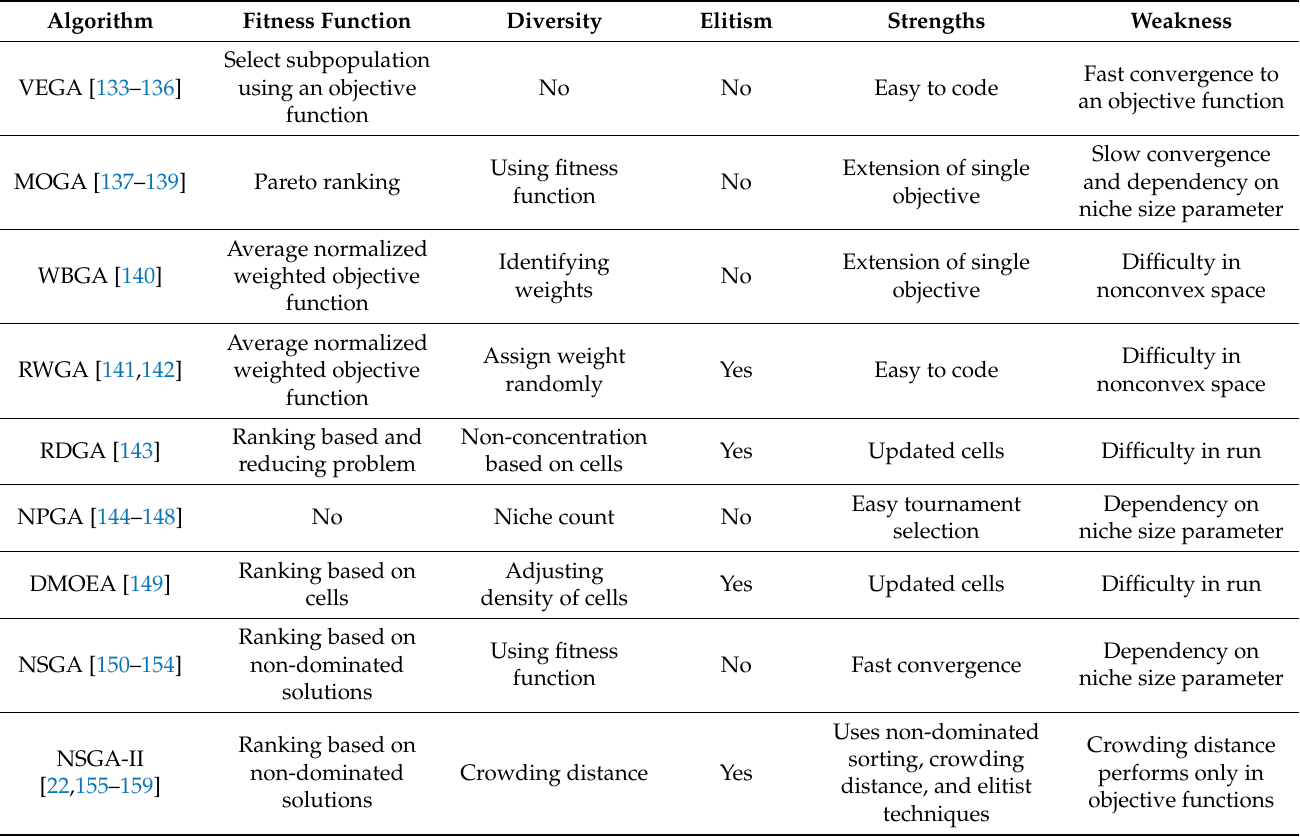
Table 2. Comparison of different GA-based solution